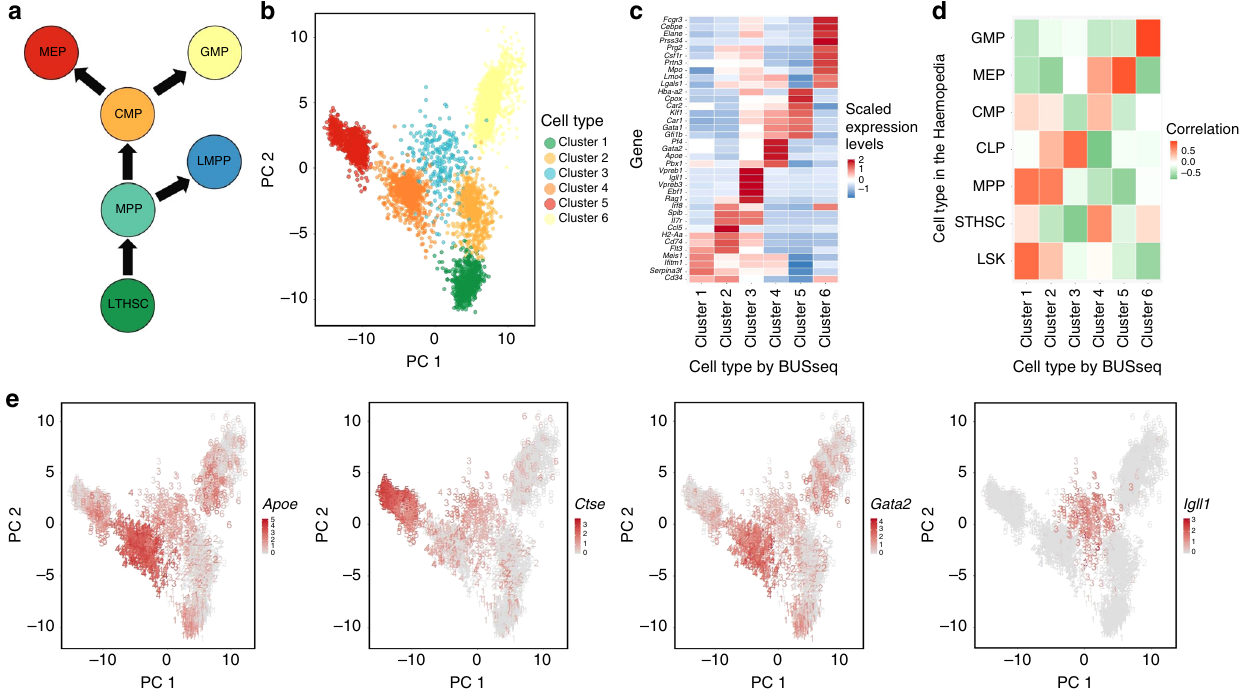
Fig. 6 BUSseq preserves the hematopoietic stem and progenitor cells (HSPC) differentiation trajectories. a The diagram of HSPC differentiation trajectories. Figure 6a is adapted from Fig. 3e of Haghverdi et al. 14 with the orientation and color coding changed. Reprinted by permission from Springer Nature, Nature Biotechnology, Batch effects in single-cell RNA-sequencing data are corrected by matching mutual nearest neighbors, Haghverdi et al. Copyright 2018. b The PCA plot of the corrected count matrix from BUSseq colored according to the estimated cell types by BUSseq. c The heatmap of scaled expression levels of key genes for HSPC. d The heatmap of correlation between gene expression pro fi les of each cell type inferred by BUSseq and those in the Haemopedia RNA-seq datasets. e The expression levels of four marker genes, Apoe , Gata2 , Ctse, and Igll1 , shown in the PCA plots of corrected count data by BUSseq, respectively. The digit labels denote the corresponding clusters identi fi ed by BUSseq.